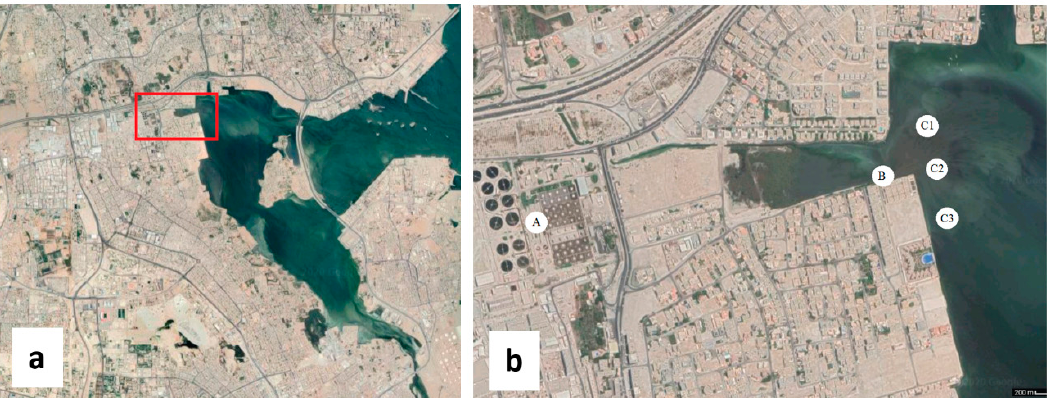
Figure 1. ( a ) Tubli Bay and the location of the sampling area. ( b ) Sampling points A: Influent